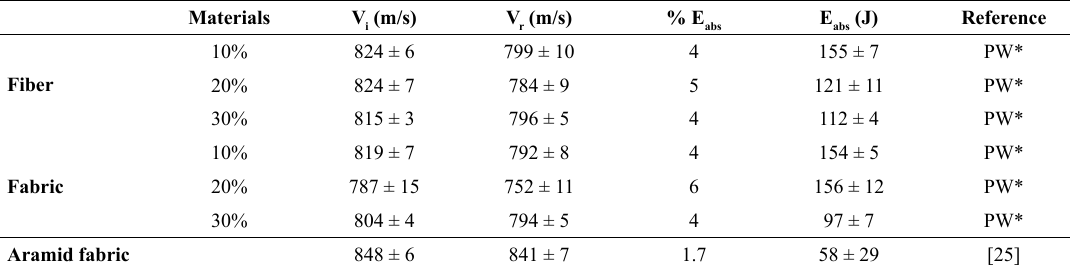
Table 2. Projectile’s absorbed energy due to ballistic